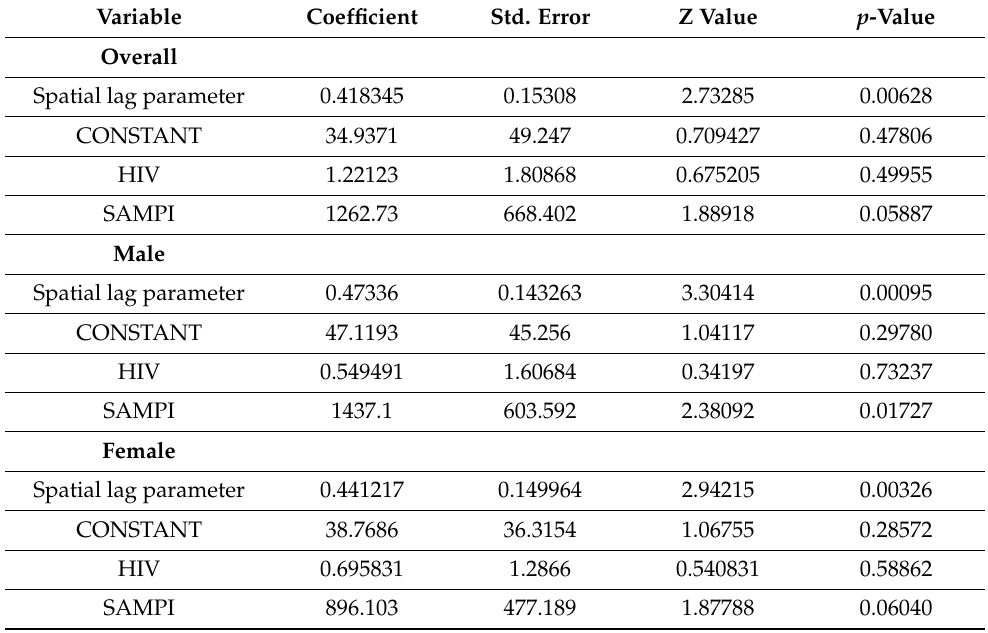
Table 3. Spatial lag regression coefficient, standard error, Z and p -values for the overall, male, and female age-sex-standardised TB death rates, 2010. Variable Std.